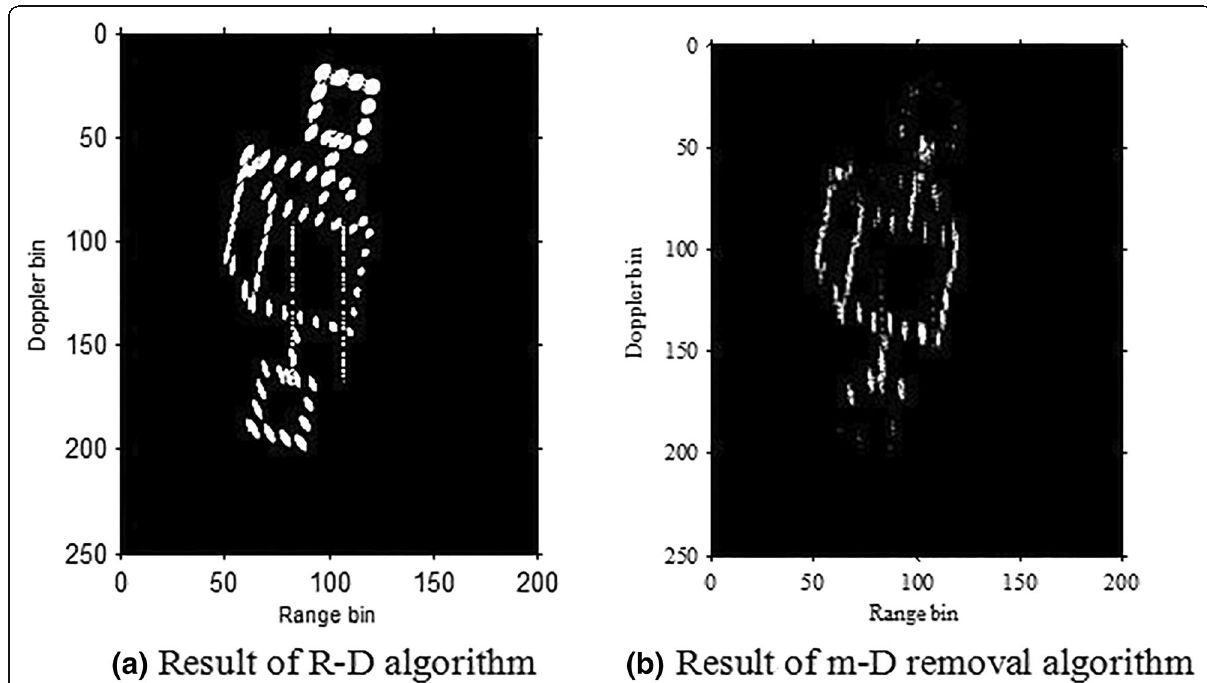
Fig. 4 Simulation results of imaging algorithm. a Result of R-D algorithm. b Result of m-D removal